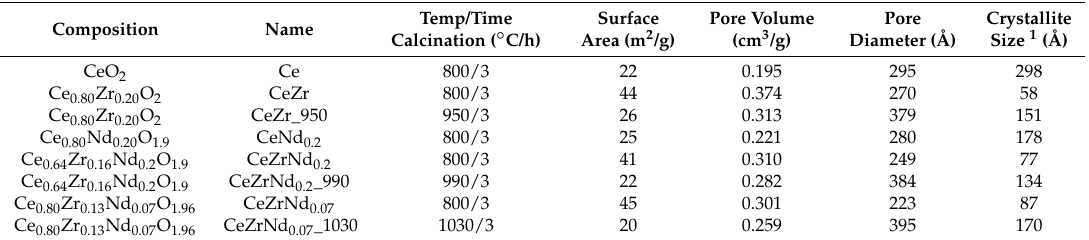
2 and of solid solutions.